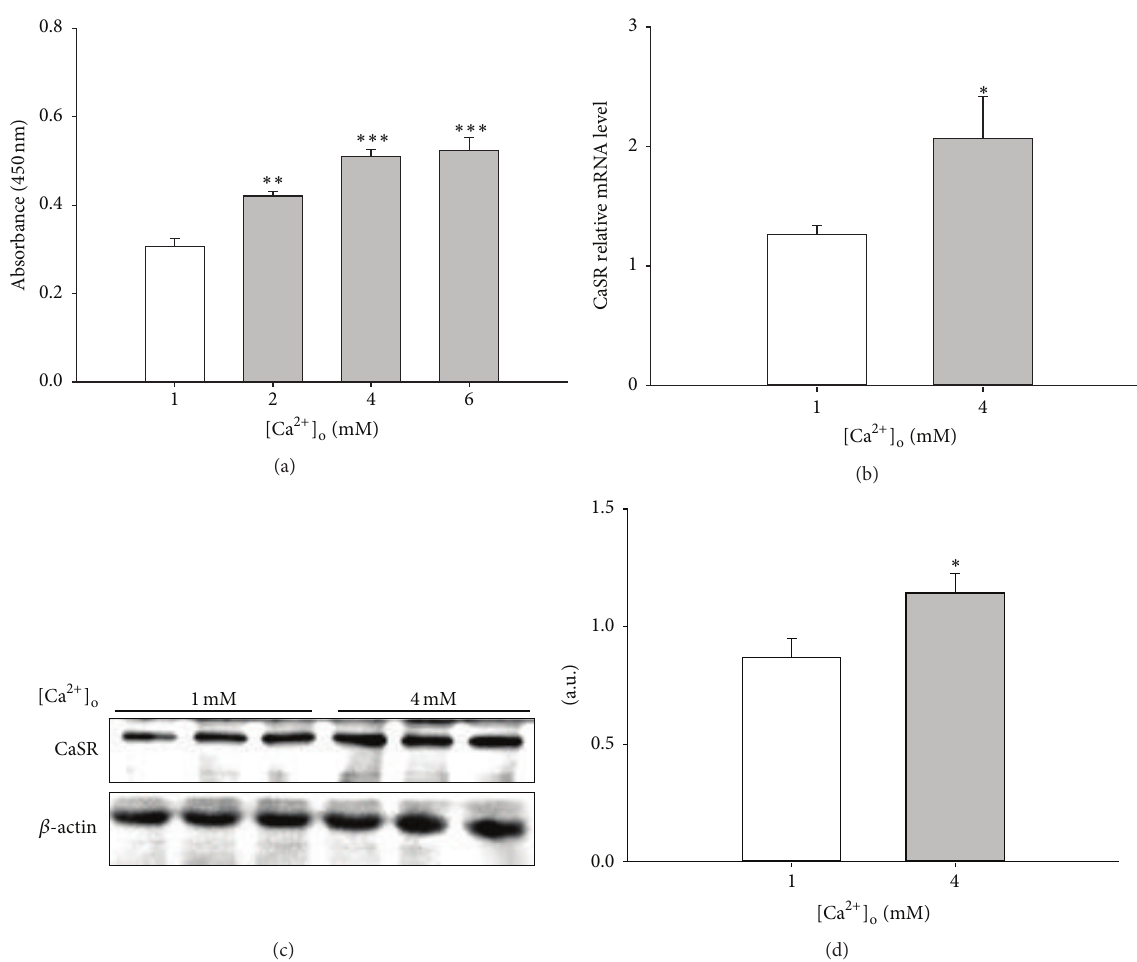
Figure 1: Extracellular calcium ( [ Ca 2+ ] o ) promoted pBMSCs proliferation and CaSR expression. (a) Effect of various [ Ca 2+ ] o (1, 2, 4, and 6 mM) on the proliferation of pBMSCs ( 𝑛 = 8 ). (b) Effect of 4mM [ Ca 2+ ] o on the mRNA expression of CaSR in pBMSCs after 5-day culture. (c) Western blot analysis of CaSR in pBMSCs after 5-day culture. 𝛽 -actin was used as loading control. (d) Mean ± SEM of immunoblotting bands of CaSR; the intensities of the bands were expressed as the arbitrary units ( 𝑛 = 3 ). ∗ 𝑃 < 0.05 , ∗∗ 𝑃 < 0.01 , and ∗∗∗ 𝑃 < 0.001 versus 1mM [ Ca 2+ ] o group